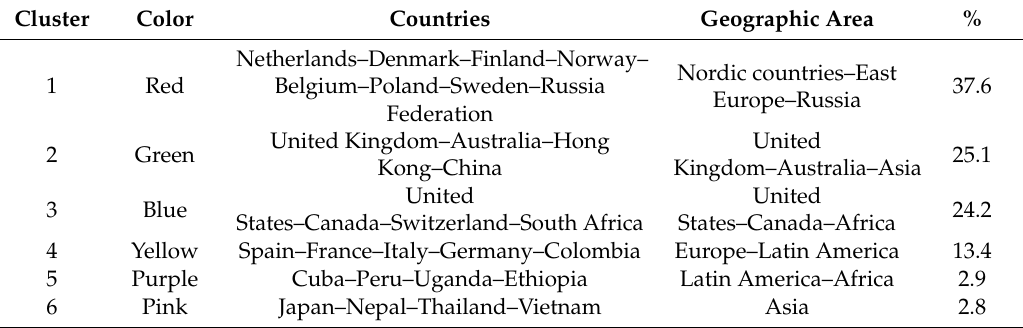
Table 2. International collaborations in research on social media related to health and young